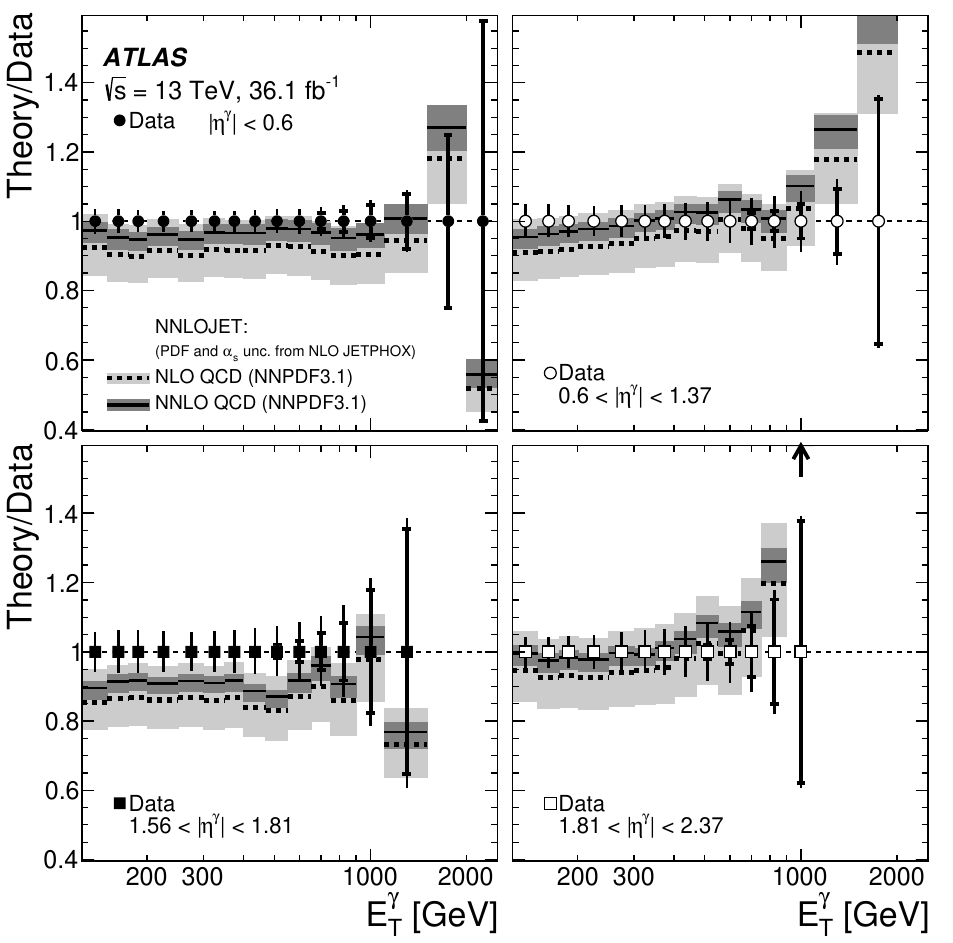
Figure 11 . The ratio of the NNLO (NLO) QCD prediction of Nnlojet using the NNPDF3.1 PDF set to the measured di(cid:11)erential cross section for isolated-photon production as a function of E (cid:13) in di(cid:11)erent regions of j (cid:17) (cid:13) j is shown as a solid (dashed) line. The symbols for the data are T centred at unity and the inner (outer) error bars represent the relative data statistical uncertainties (statistical and systematic uncertainties added in quadrature). The shaded bands represent the theoretical uncertainties, which include those due to the PDFs and (cid:11) s as estimated at NLO with Jetphox